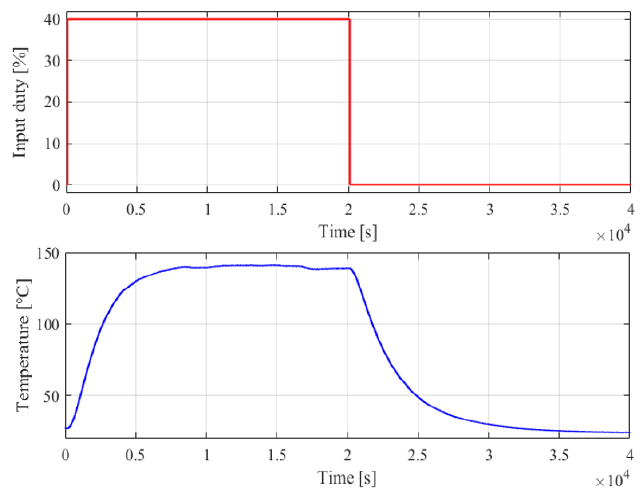
Figure 4. Imported input signal and obtained output data for the thermal process, involving the temperature going up and down from the room